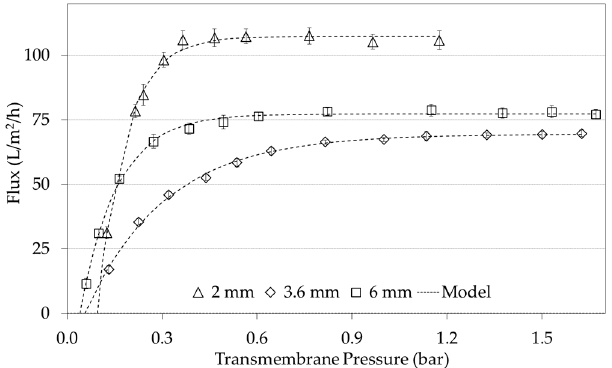
Figure 5. Flow of 7.38 L/min. Experimental conditions: concentration factor 1.5 at 50°C.